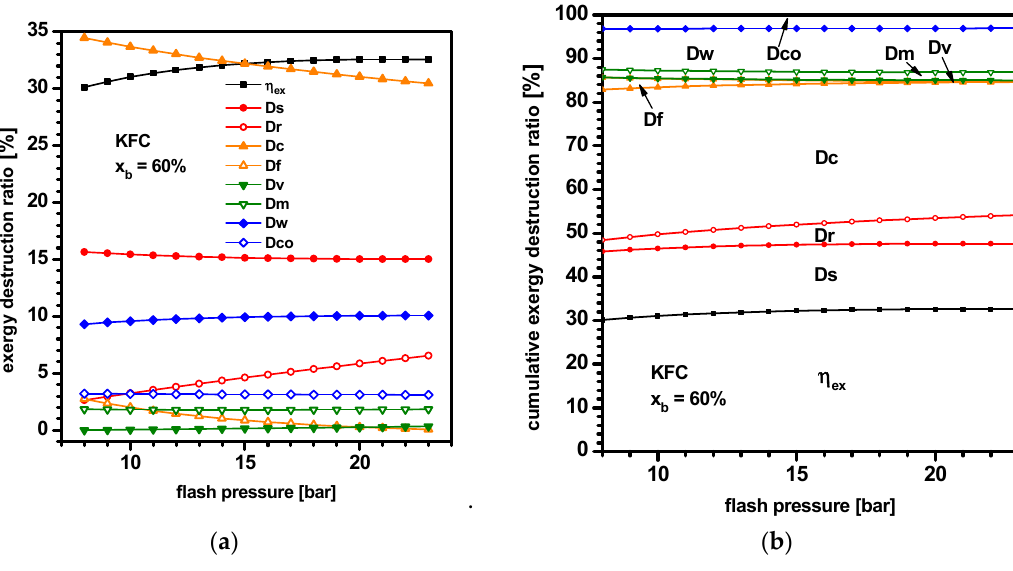
Figure 5. Dependence of ( a ) separate and ( b ) cumulative ratios of exergy consumption on the flash pressure for x b =